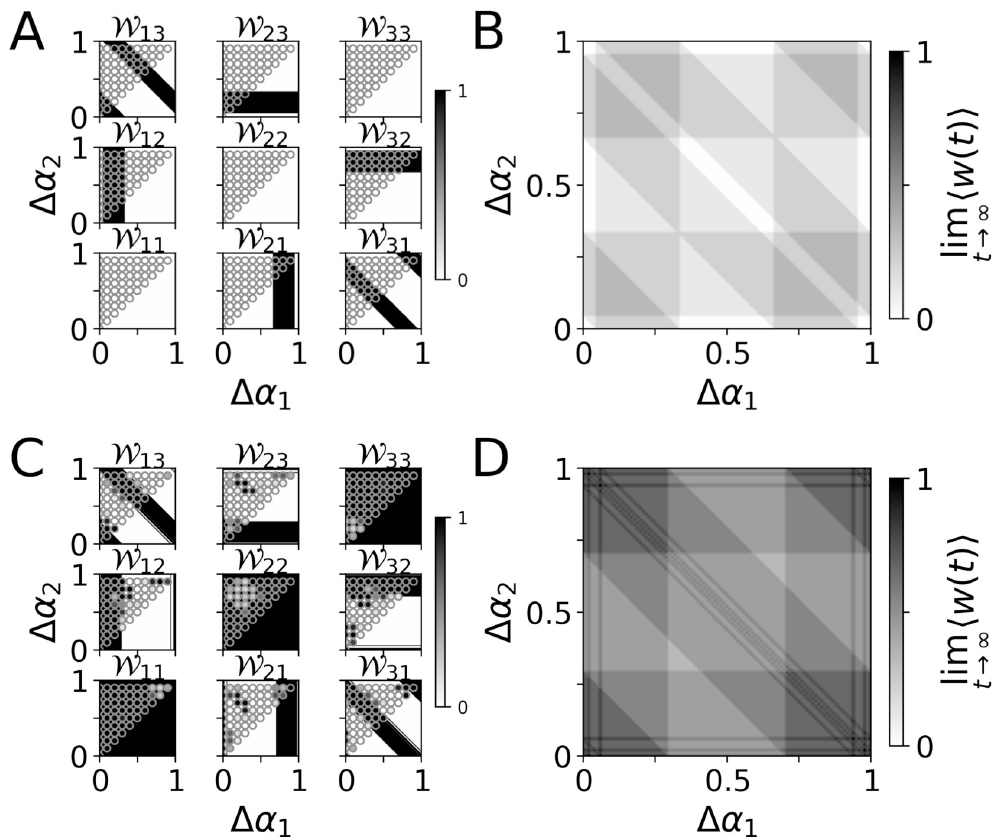
Fig 5. PMCS-induced network structure depends on phase lags between stimulus trains. Predicted block structure of the synaptic weight matrix W after long PMCS employing single-pulse stimuli (A, B) and PMCS employing burst stimuli consisting of three pulses (C, D). A: lim x ! y h w x ! y ( t ) i , obtained from Eq 1, (color map) is compared to simulation results for the LIF network model after 1000 sec of stimulation (filled circles). B: Predicted mean synaptic weight lim obtained from Eq 4. C,D: Same as A,B but for burst stimuli with three pulses per burst and an intraburst frequency of 120 Hz. Parameters: A stim = 0.4, f = 10 Hz, d e = 1 (A,B), and A stim = 0.8, f = 5 Hz, d e = 1, and an intraburst frequency of 120 Hz (C,D).